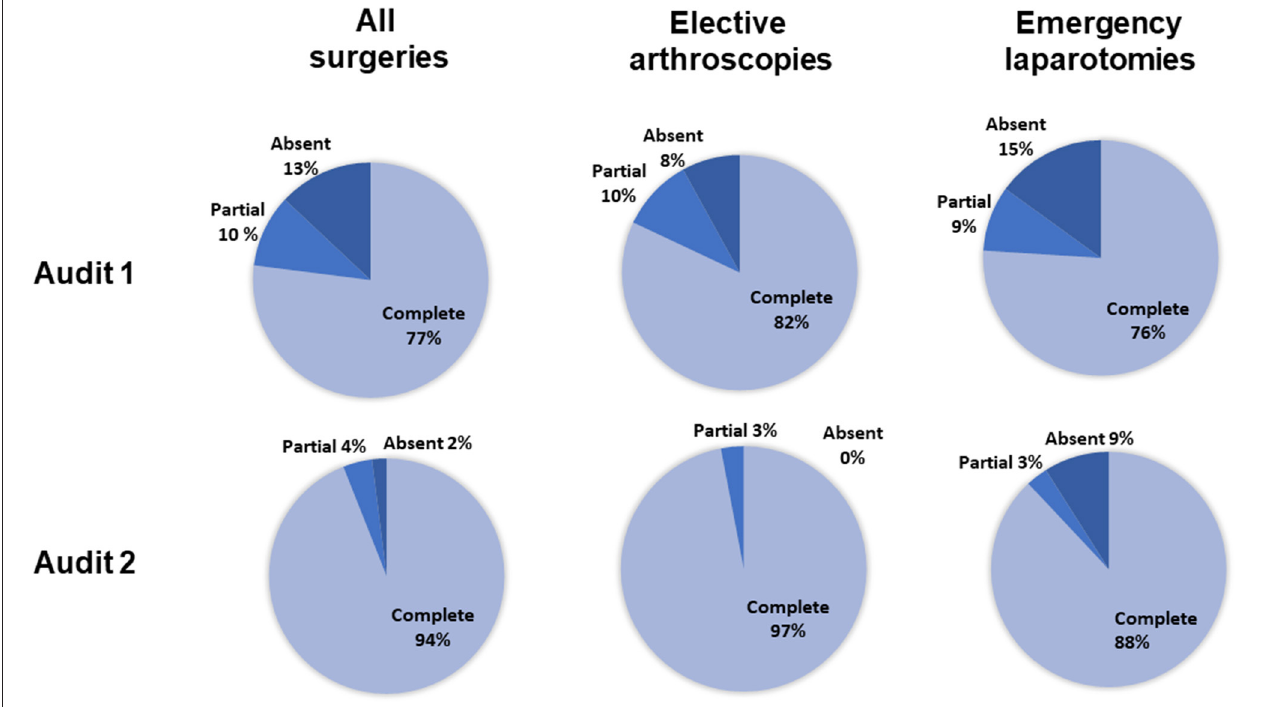
FIGURE 1 | The percentage of complete, incomplete, or absent antimicrobial recordings for all surgeries, elective arthroscopies, and emergency laparotomies, in audits 1 and 2. Percentages were calculated from the total number of animals scheduled to receive preoperative antimicrobials (136 in the first audit and 170 in the second audit). For the elective arthroscopy and emergency laparotomy groups, percentages were calculated from the total number of procedures performed given that all received preoperative antimicrobials (arthroscopies: 60 first audit, 62 second audit; laparotomies: 33 first audit, 35 second